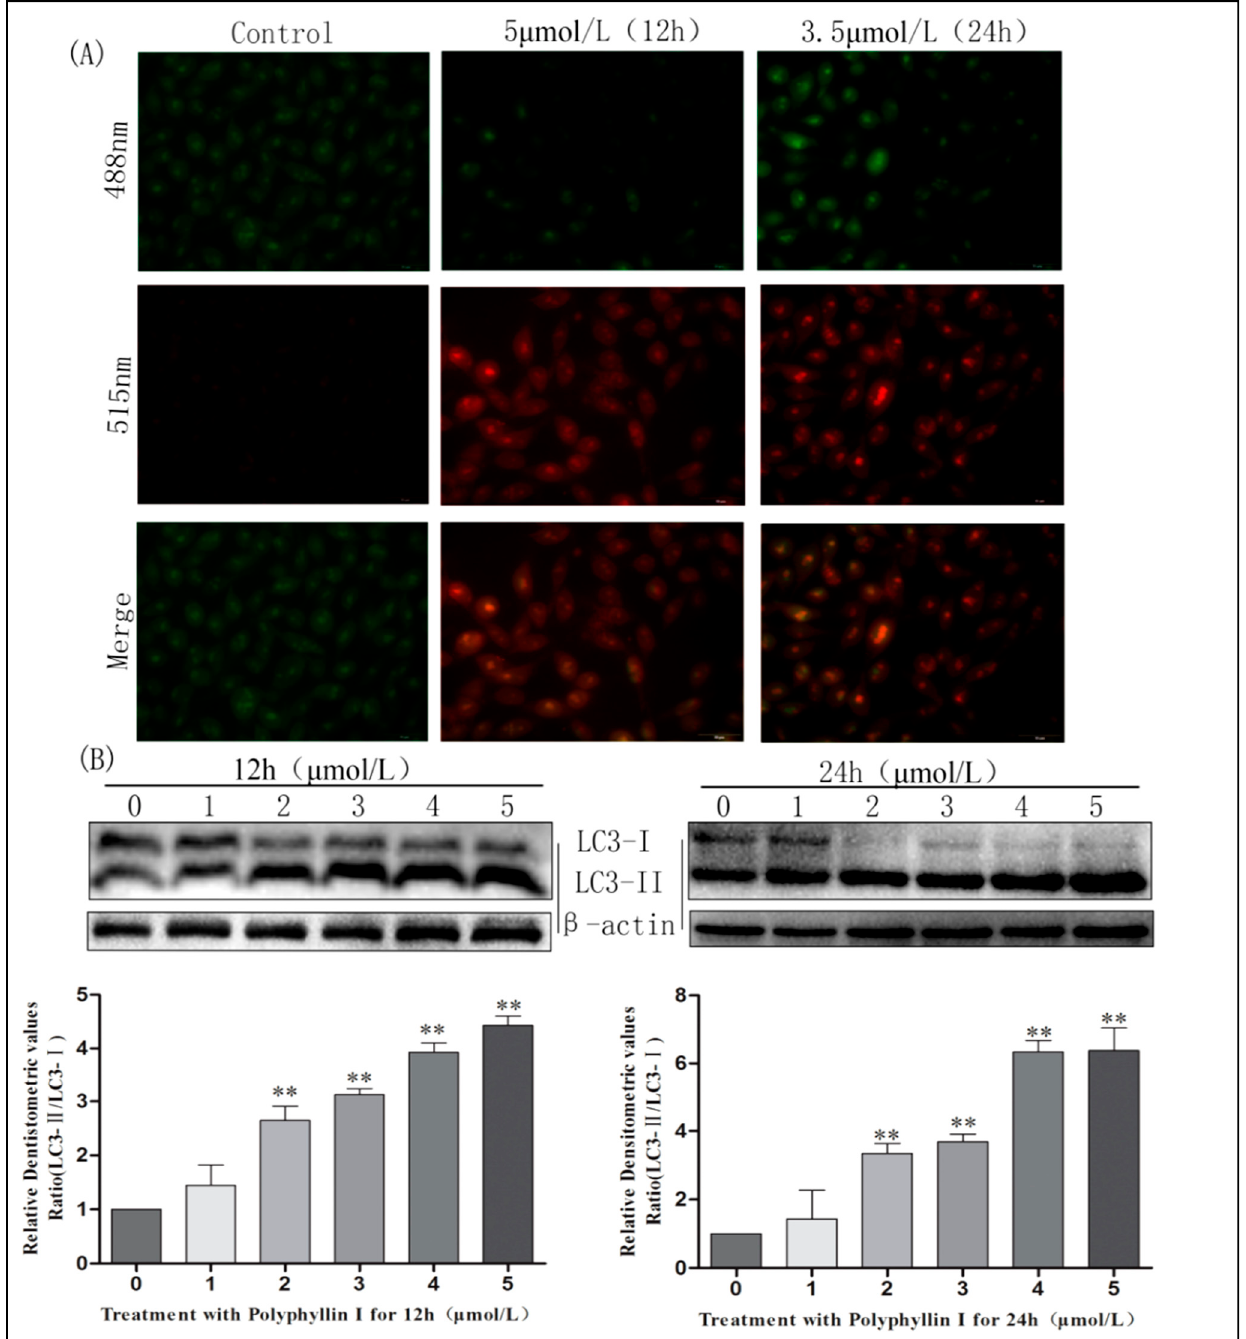
Figure 3. PPI induced autophagy in SW480 cells. ( A ) AO staining showed acidic autophagic vesi ‐ cles (1000×). ( B ) Autophagic marker LC3 protein was examined by Western blot assay and quanti ‐ (1000 × ). ( B ) Autophagic marker LC3 protein was examined by Western blot assay and fication of the ratio of LC3 ‐ II to LC3 ‐ I. n = 3, the data are presented as means ± SEM. ** p < 0.01.